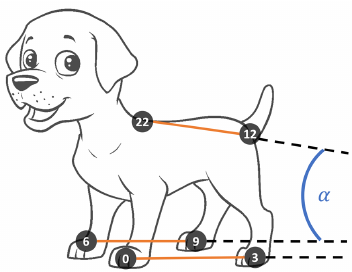
Figure 3. Calculation of the body weight